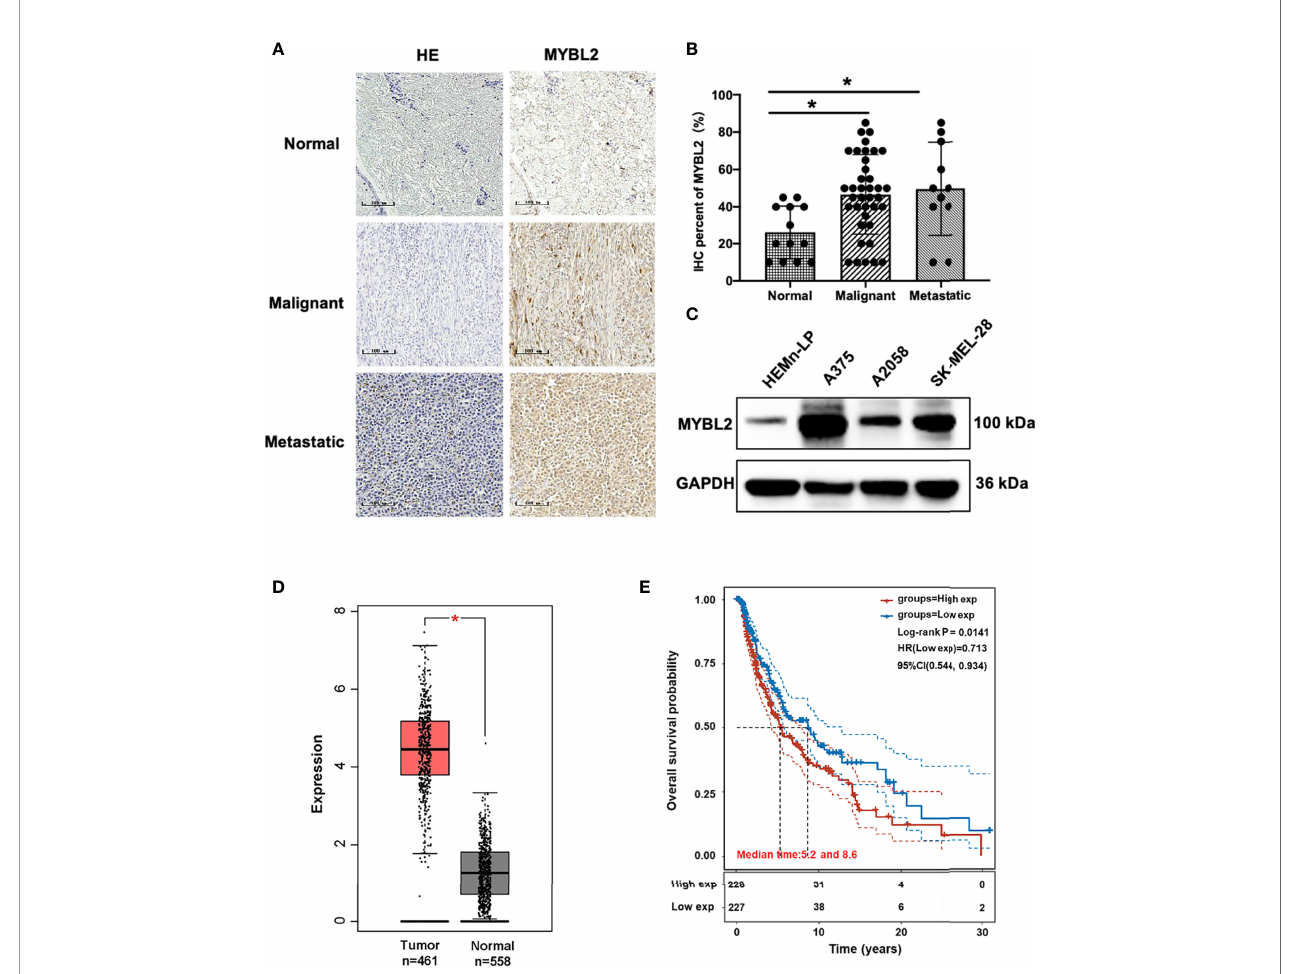
FIGURE 1 | MYBL2 is upregulated in patients with melanoma. (A) IHC was performed to detect the expression of MYBL2 in normal skin tissue, malignant melanoma, and metastatic malignant melanoma samples (×200). (B) Analysis of IHC showing MYBL2 expression. (C) Western blot analysis of MYBL2 in three distinct cell lines: normal stage (HEMn-LP), onset of malignant melanoma (A375 and SK-MEL-28), and metastatic stage (A2058). (D) MYBL2 expression in 558 normal human and 461 melanoma patients. Analysis of MYBL2 mRNA expression across various types of samples based on the melanoma dataset from The Cancer Genome Atlas Genomic Commons (TCGA-GDC) Data Portal using GEPIA interactive web server. Normal skin sample data were obtained from the GTEx database. (E) High MYBL2 expression level correlated with poor survival of melanoma patients. Kaplan – Meier curve analysis based on the TCGA Skin Cutaneous Melanoma (SKCM) dataset showing melanoma patient overall survival grouped by high MYBL2 mRNA expression level (upper quartile, n = 120) versus those with low MYBL2 expression level (lower quartile, n = 120). * p <